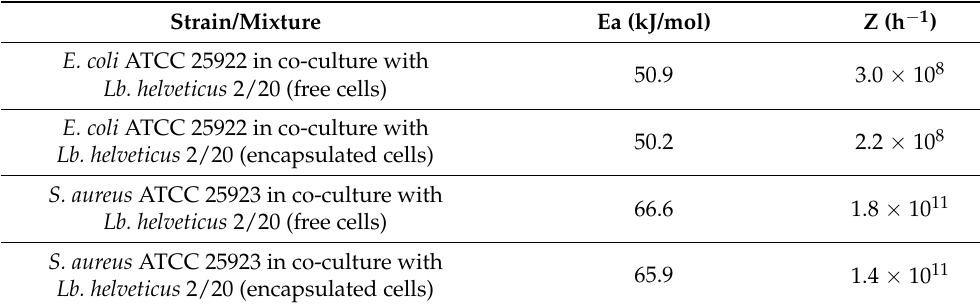
Table 5. Activation energy of death and pre-exponential multiplier in the Arrhenius equation for S. aureus ATCC 25923 and E. coli ATCC 25922 in chocolate mousse. Strain/Mixture